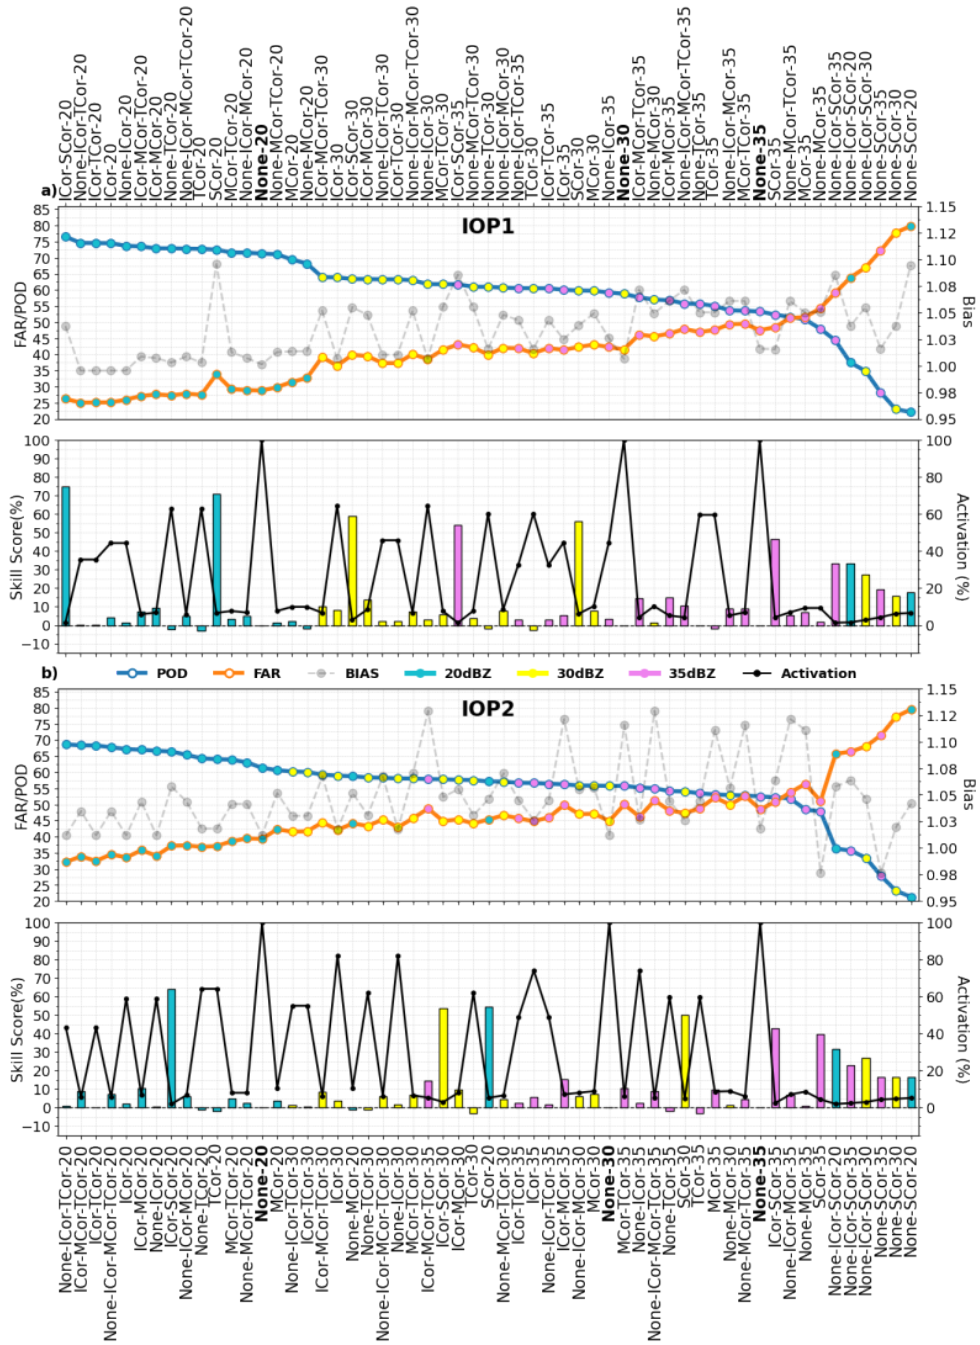
Figure 10. Evaluation of all methods according to statistical index (POD/FAR/BIAS), Skill Score and Activation Frequency of the vector correction methods for each radar intensity identification threshold during IOP1 ( a ) and 2 ( b